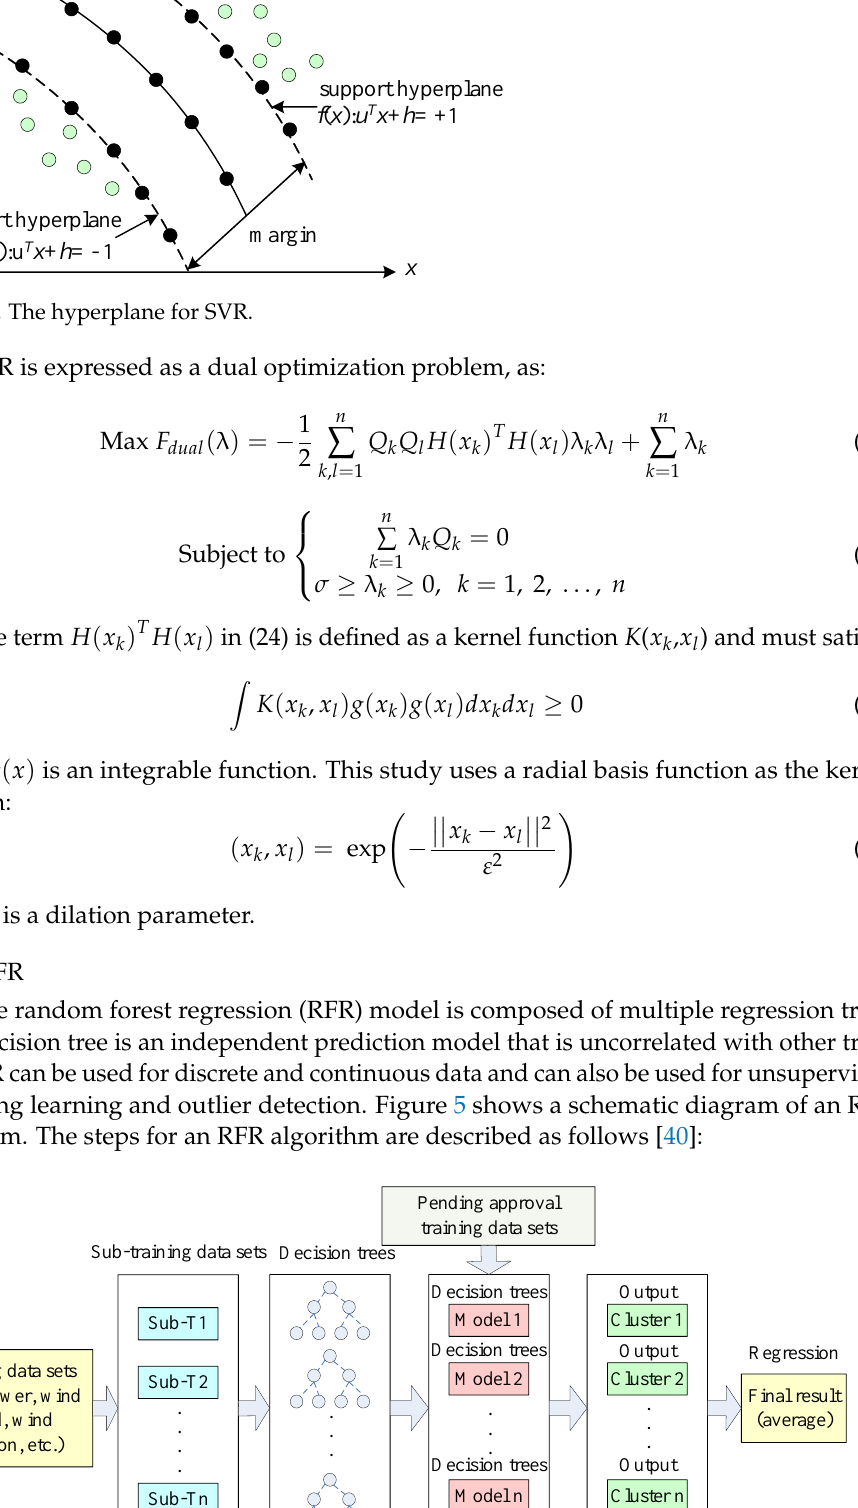
Figure 5. Schematic diagram of an RFR algorithm. Table 1. Comparison of the five single models. Method